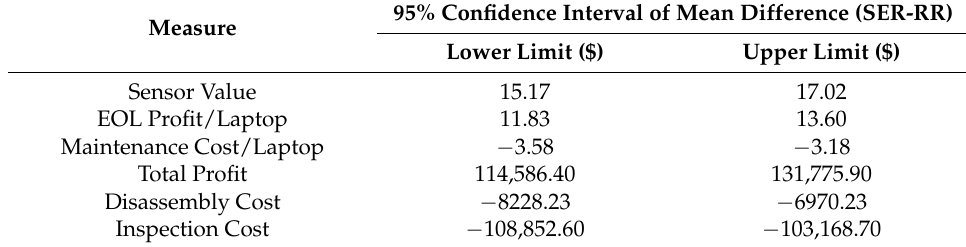
Table 12. 95% Confidence interval of mean